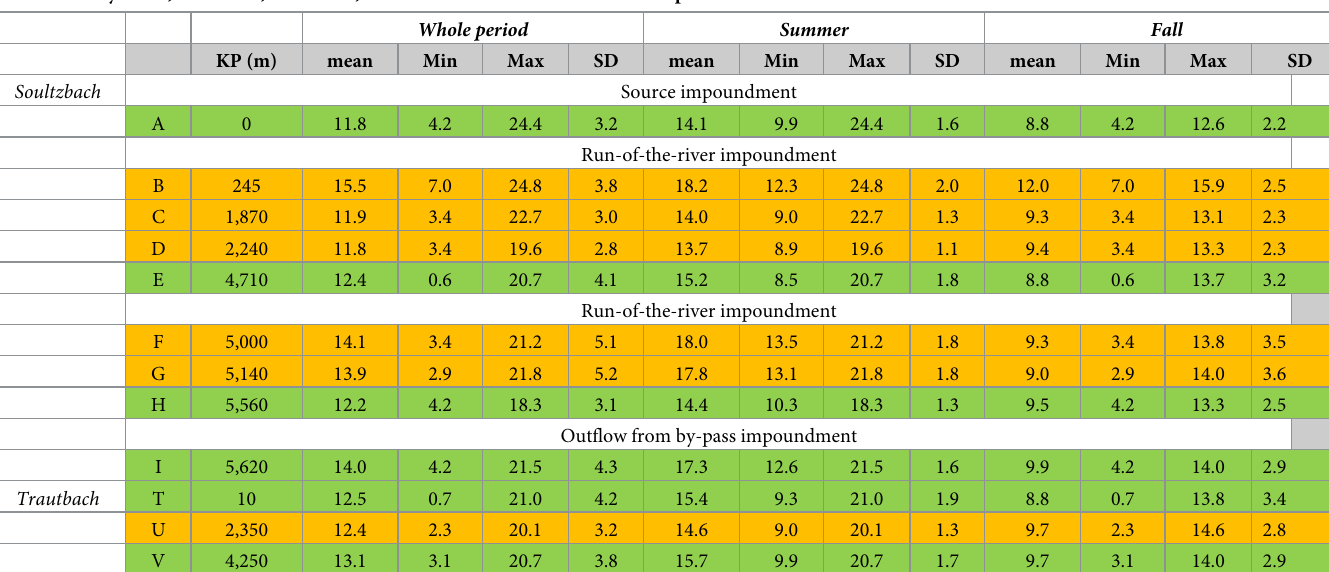
Table 3. Daily mean, minimum, maximum, and standard deviation of stream temperature.